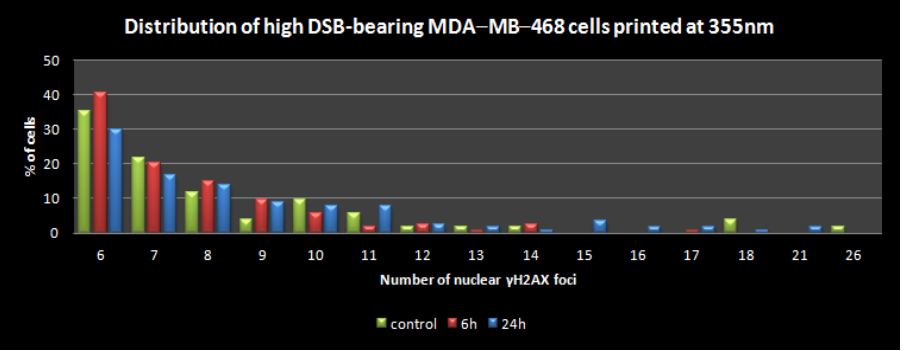
Figure 11. The distribution of high (>5)-DSB-bearing MDA-MB-468 cells in terms of γ H2AX foci per nucleus.